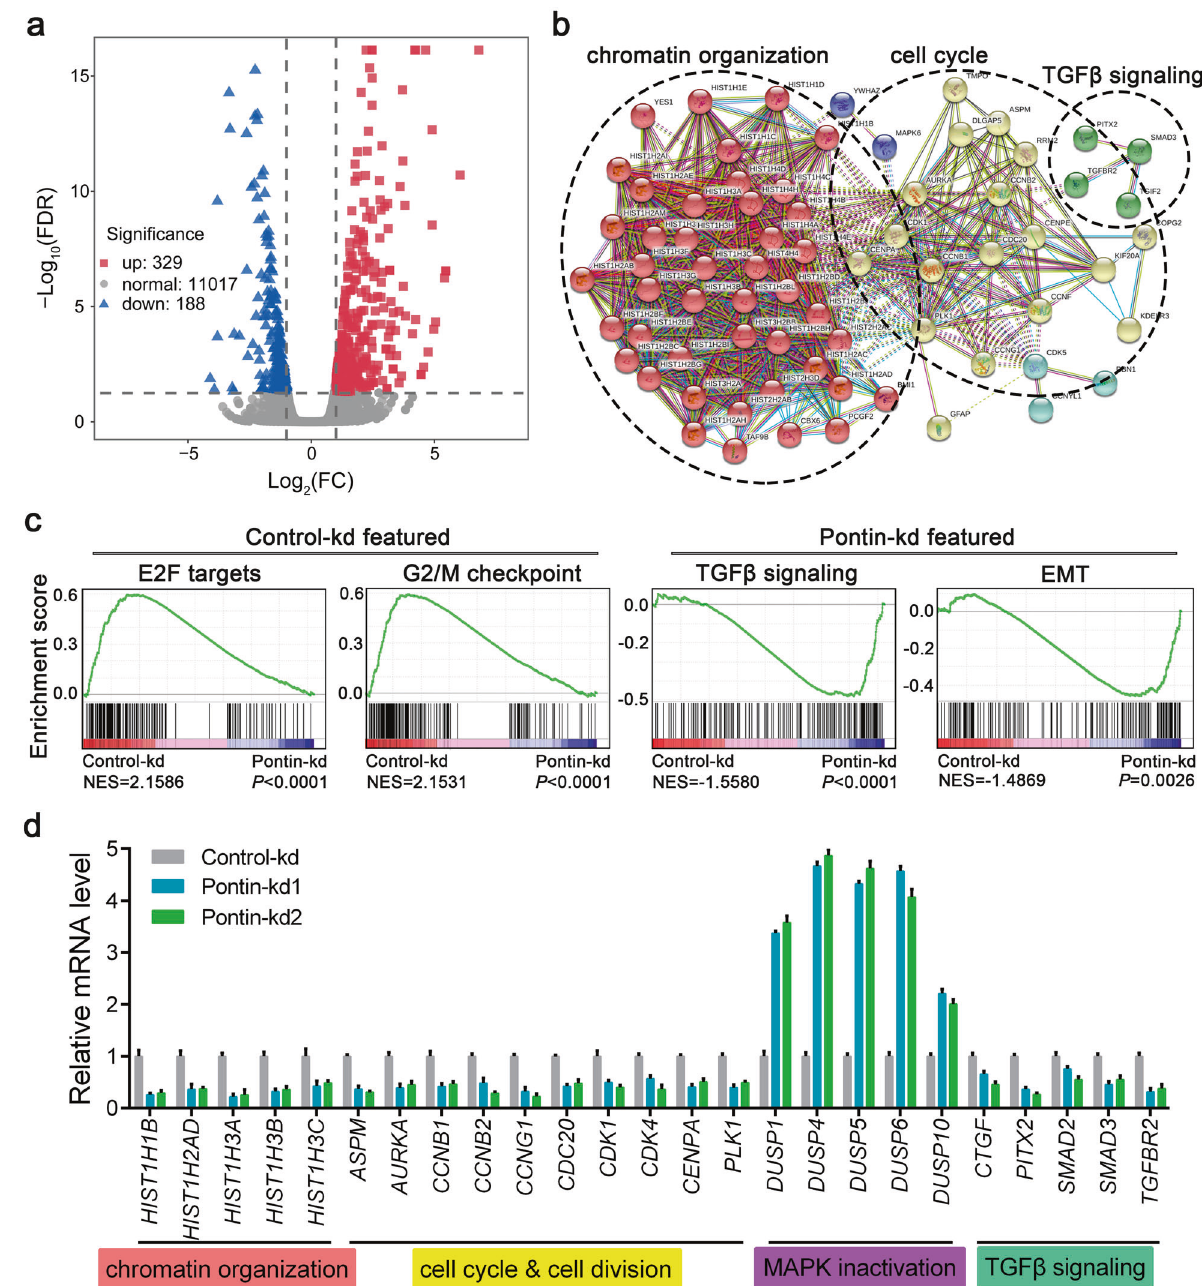
Fig. 4 Global pro fi les of Pontin-regulated differential gene expression and cellular signalling in GBM cells. a Differential expressed coding genes affected by Pontin knockdown screened by RNA-seq (FC > 2, FDR < 0.05) were used to make the Volcano plot. b Downregulated genes incorporated in a were analyzed using STRING to plot the protein-protein association network with respective function annotation. c GSEA plots suggested a prominent correlation between Pontin and cellular signalling. d qRT-PCR con fi rmation of Pontin-regulated expression of genes involved in several biological processes or cellular signalling in indicated U87MG cells. Data are expressed as means ± SDs, n =